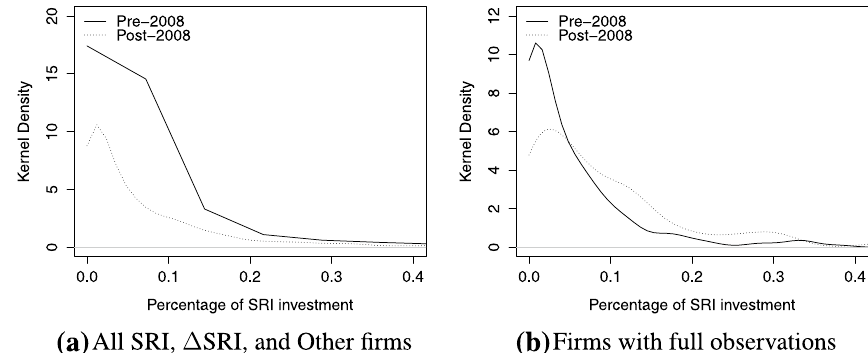
Fig. 2 Distribution of SRI investment in SRI, (cid:31) SRI, and Other firms in periods